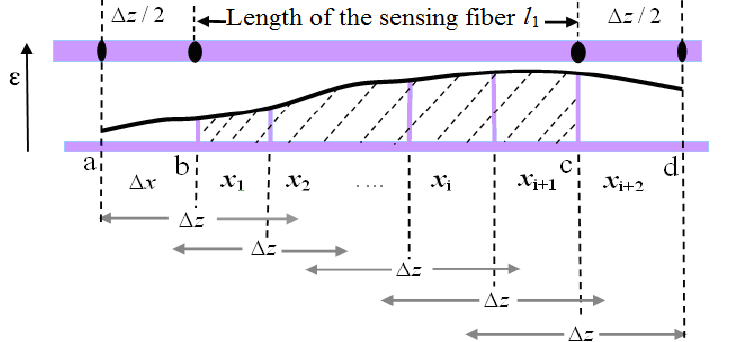
Figure 3. The distributed strain along with the sensing